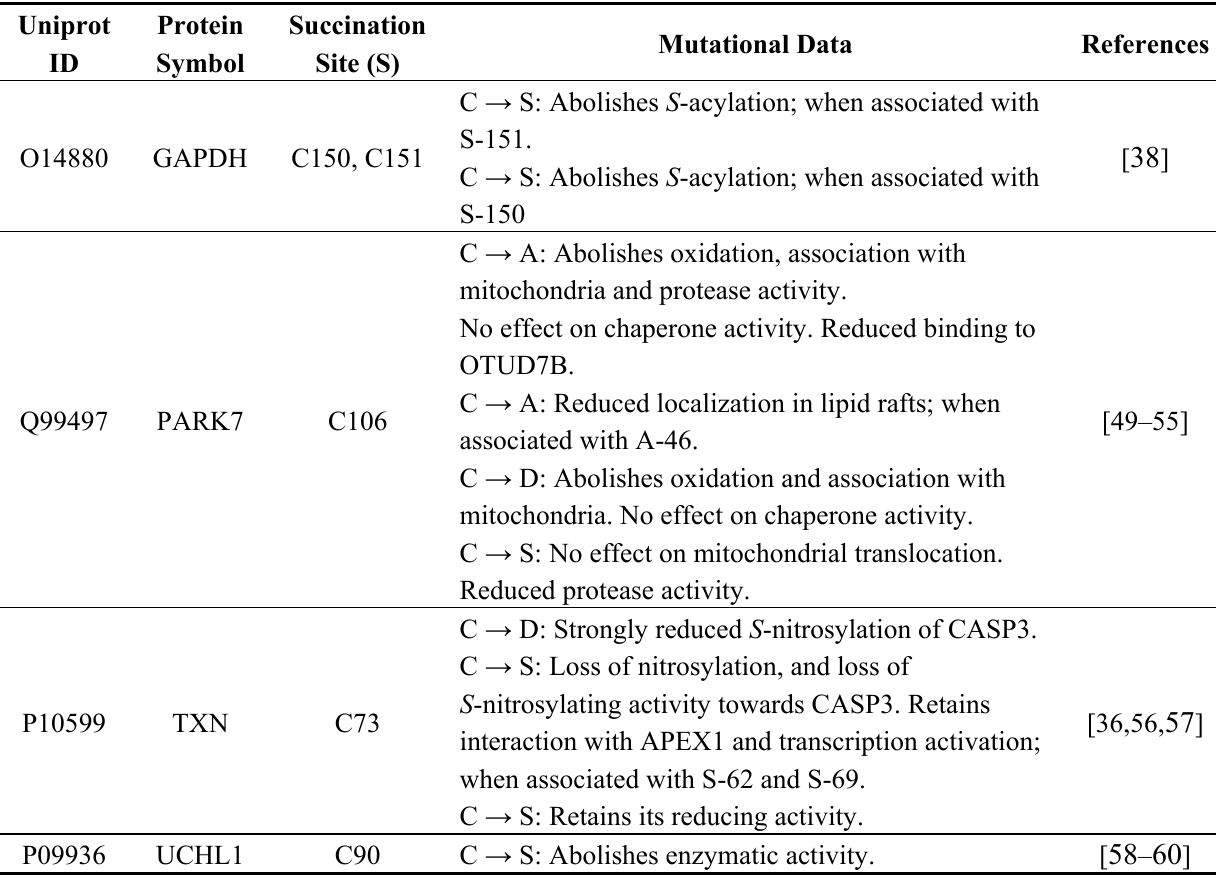
Table 3. Mutational studies on cysteine residues observed to be succinated in FH-mutant tumours and cancer